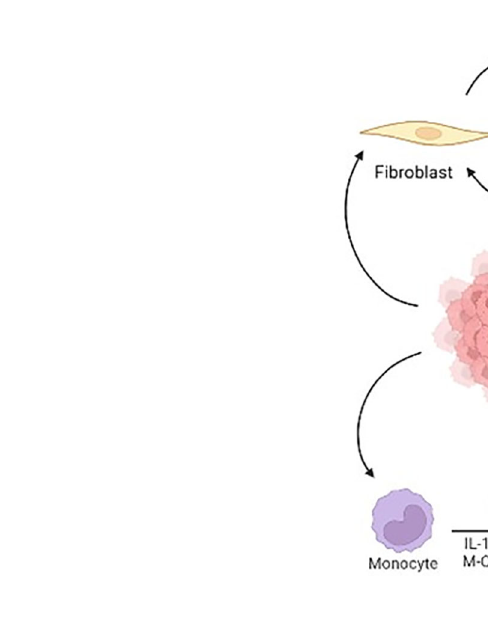
Figure 2 is a schematic representation of the cellular components of Pheo/PGL TME.